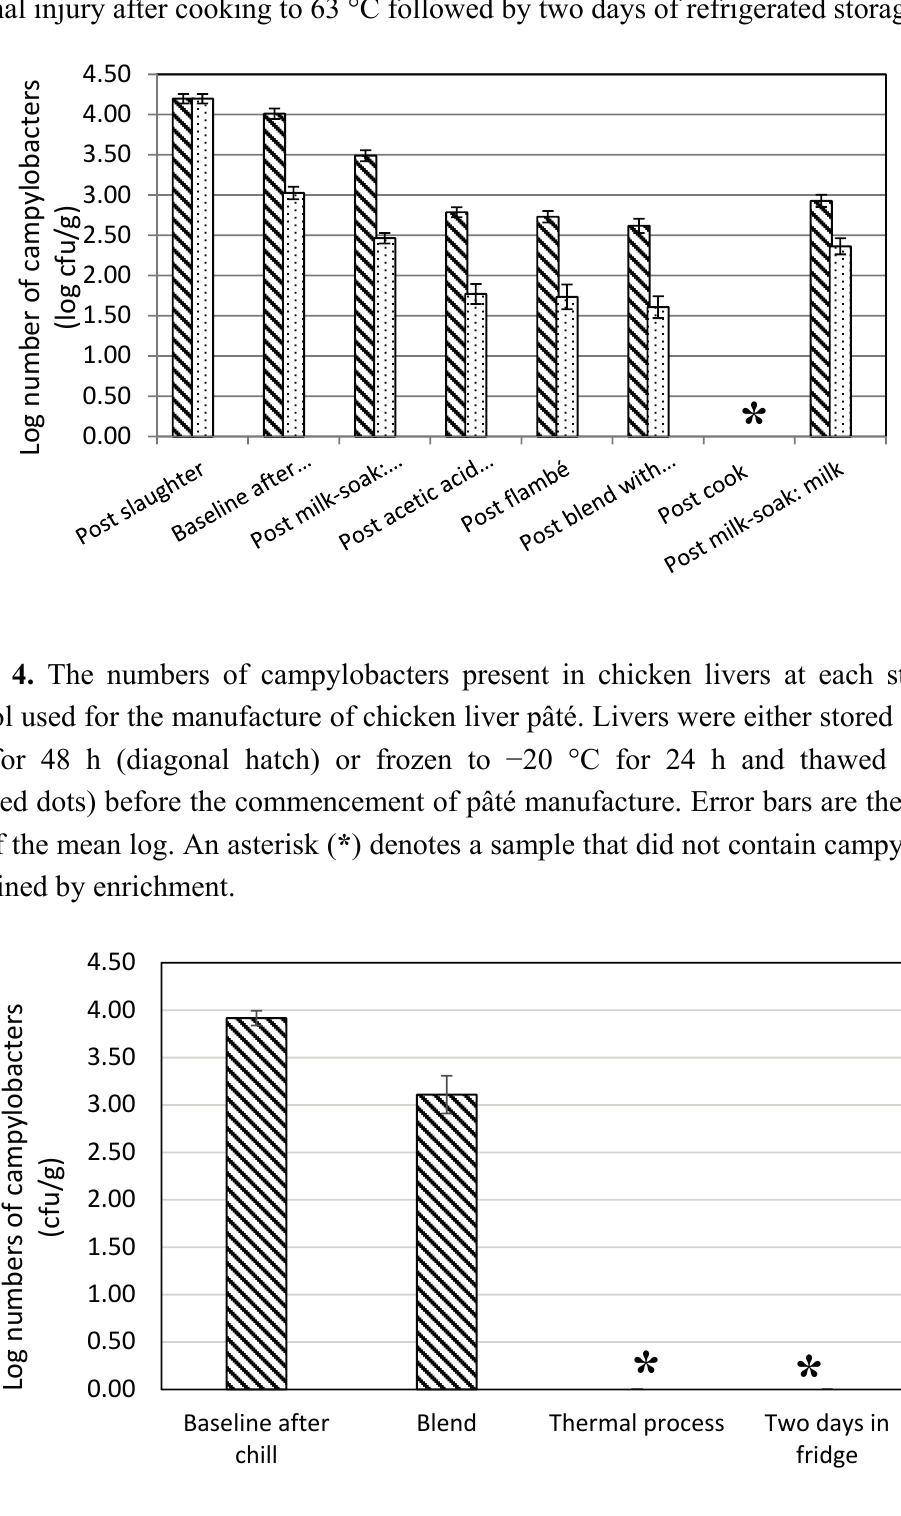
Figure 5. The numbers of campylobacters present in chicken livers before and after cooking in a Bain Marie under worst-risk conditions. Fresh livers from final clearance birds were prepared only by blending with an equal mass of molten butter before cooking and refrigerated storage to determine recovery from sub-lethal injury. An asterisk ( * ) denotes a sample that did not contain campylobacters determined by